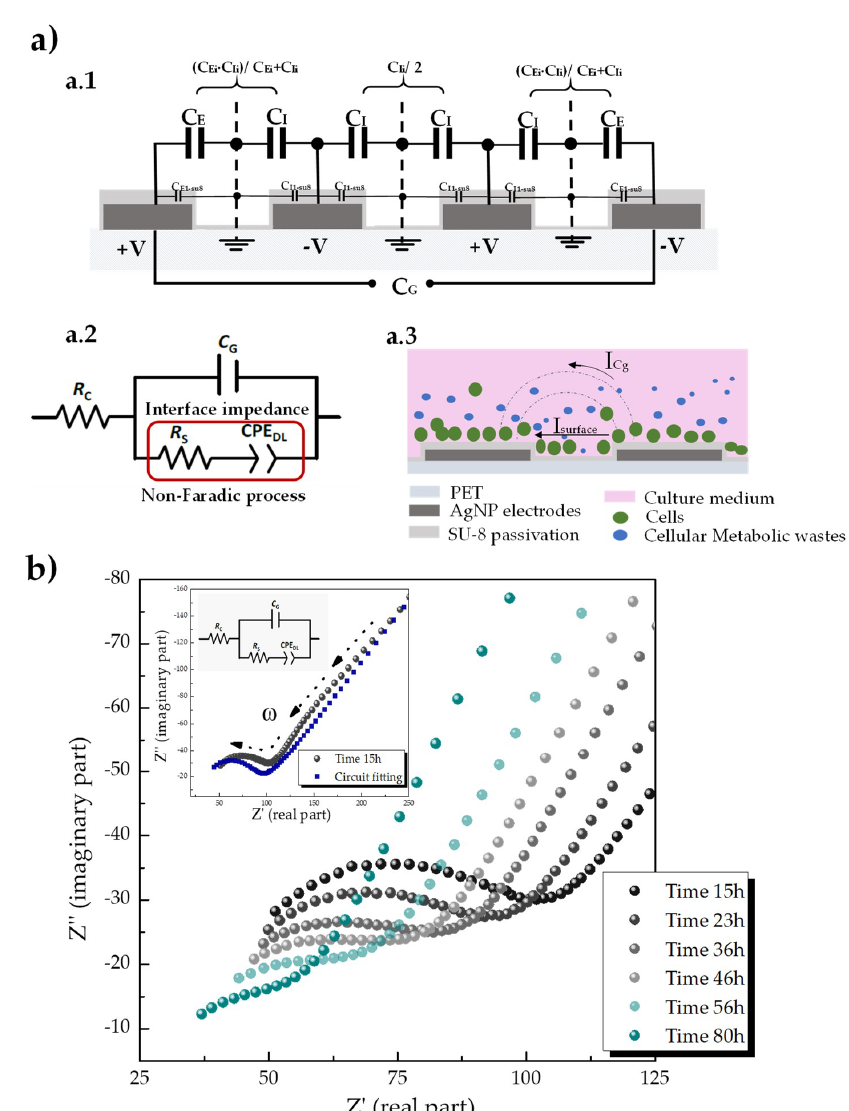
Figure 7. ( a ) Equivalent circuit model to fit the impedance measured in a non-faradic analysis. a.1